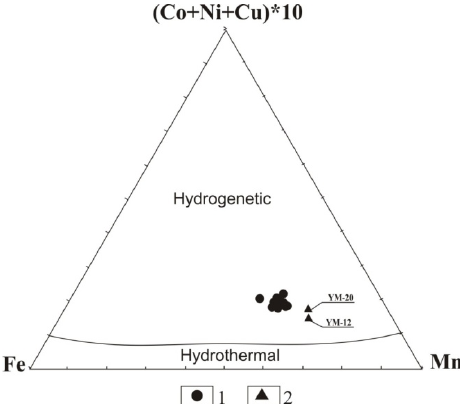
Figure 5. Fe-Mn deposits from Yōmei Guyot on the Mn-Fe-(Cu+Co+Ni) × 10 ternary diagram [28]. 1—samples composed by vernadite; 2—samples composed by 10Å and 7Å manganates (Table 2).